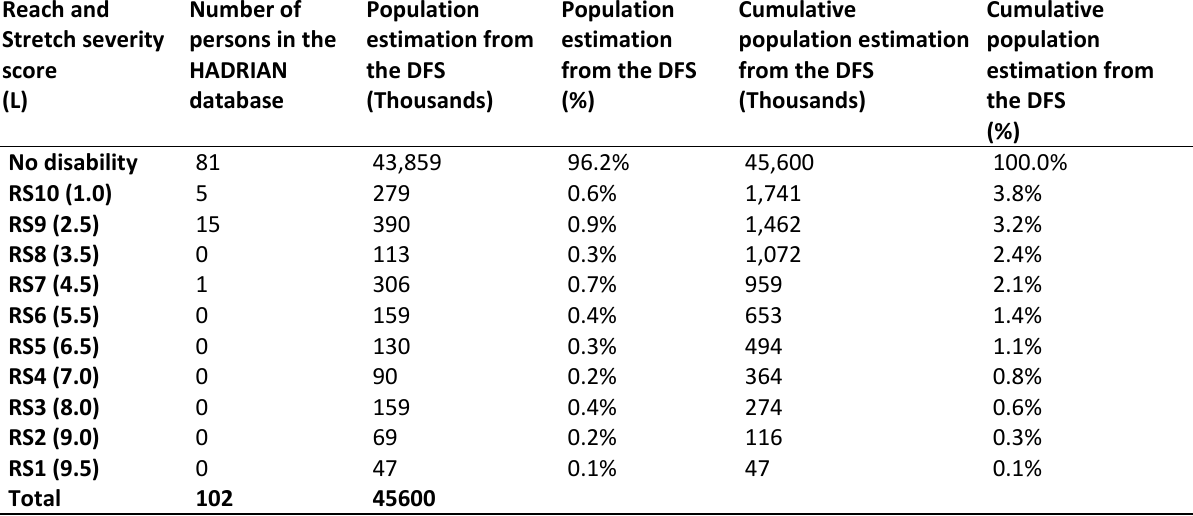
Table 7. HADRIAN severity scores and DFS-based population estimation for reach and stretch. Reach and Stretch